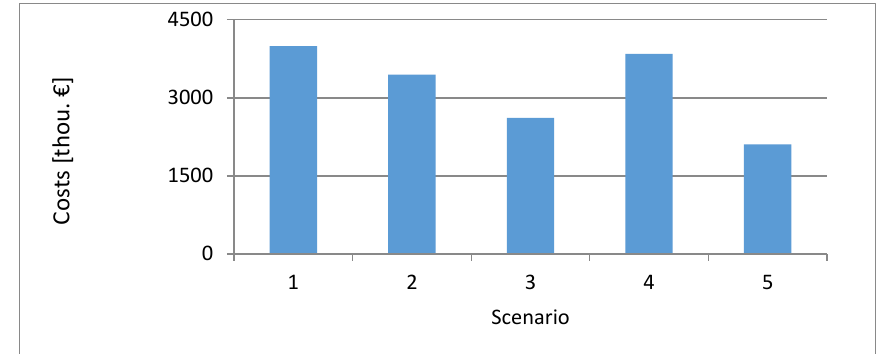
Figure 7 Total costs of the development of the distribution system.